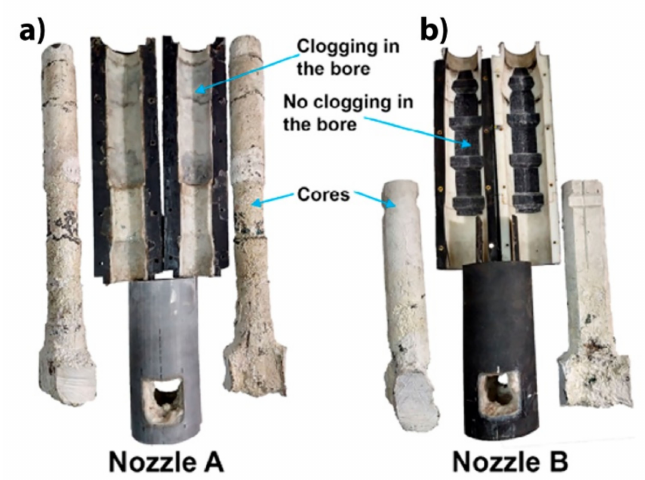
Figure 5. Geometric features of the nozzles. ( a ) Nozzle A. ( b ) Nozzle B. The bores of the bodies of both nozzles have diameters 1.0 mm larger than the original ones indicated in the blueprints. This machining operation compensates for the gap’s interface thickness between the nozzle’s interior surface and the rubber, modeling the presence of the clogs. Figure 5a,b show the nozzle A and nozzle B models, respectively.